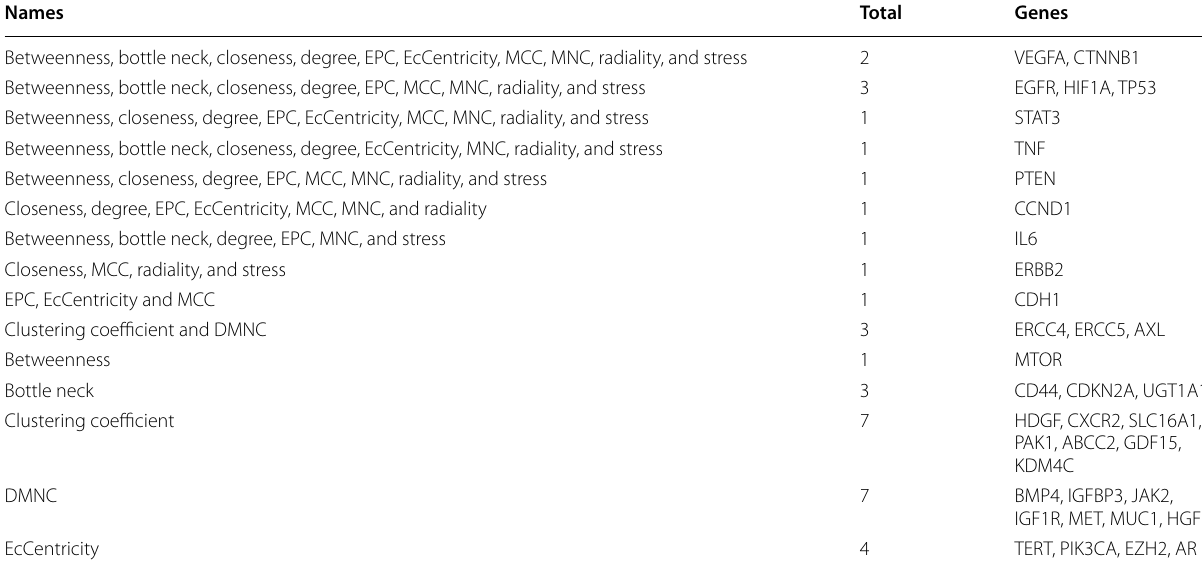
Table 5 Common hub genes between the top ten hub genes obtained by 12 different topological analysis